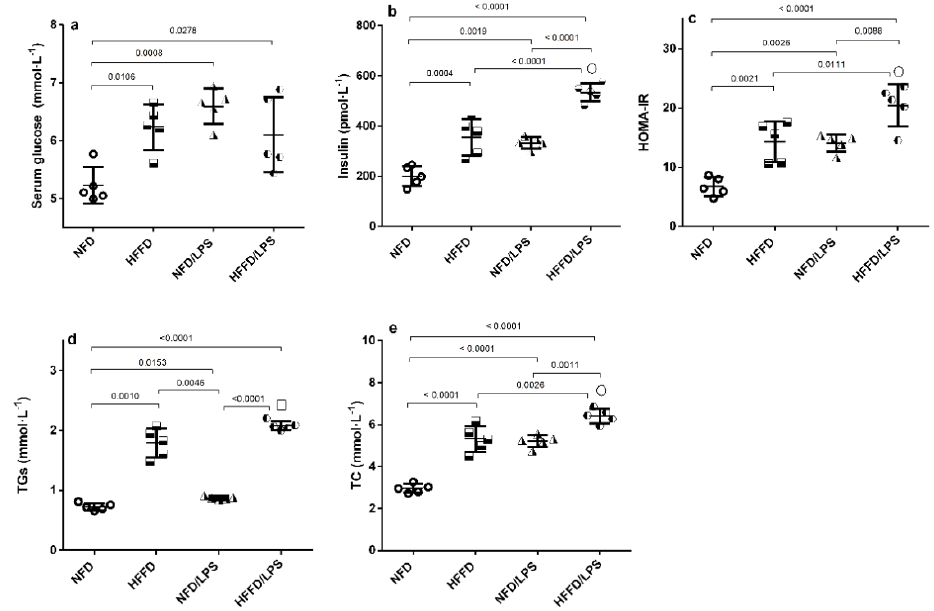
Figure 1. Effects of LPS and/or HFFD on glucose homeostasis parameters [( a ) glucose, ( b ) insulin, ( c ) HOMA-IR], and lipid profile [( d ) TGs and ( e ) TC] in rats after 9 weeks. Values are shown in scatter plots and expressed as mean ± SD ( n = 5/group). Glucose, insulin, HOMA-IR and TC were analyzed using one-way ANOVA followed by Tukey ’ s post hoc test, while Welch ’ s ANOVA was performed followed by Dunnett ’ s T3 Multiple Comparison test for TGs to account for heterogeneity; p < 0 .05. The symbols (□) and ( ○ ) indicate additive and synergistic interactions, respectively, using coefficient drug index (CDI). Rats were fed NFD or HFFD for 8 weeks and then received or not a single dose of LPS (2 mg·kg −1 , i.p). All groups continued on NFD for another week. HFFD: high fat-fructose diet; HOMA-IR: Homeostasis Model Assessment of insulin resistance; LPS: lipopolysaccharide; NFD: normal fat diet; TC: total cholesterol; TGs: triglycerides.